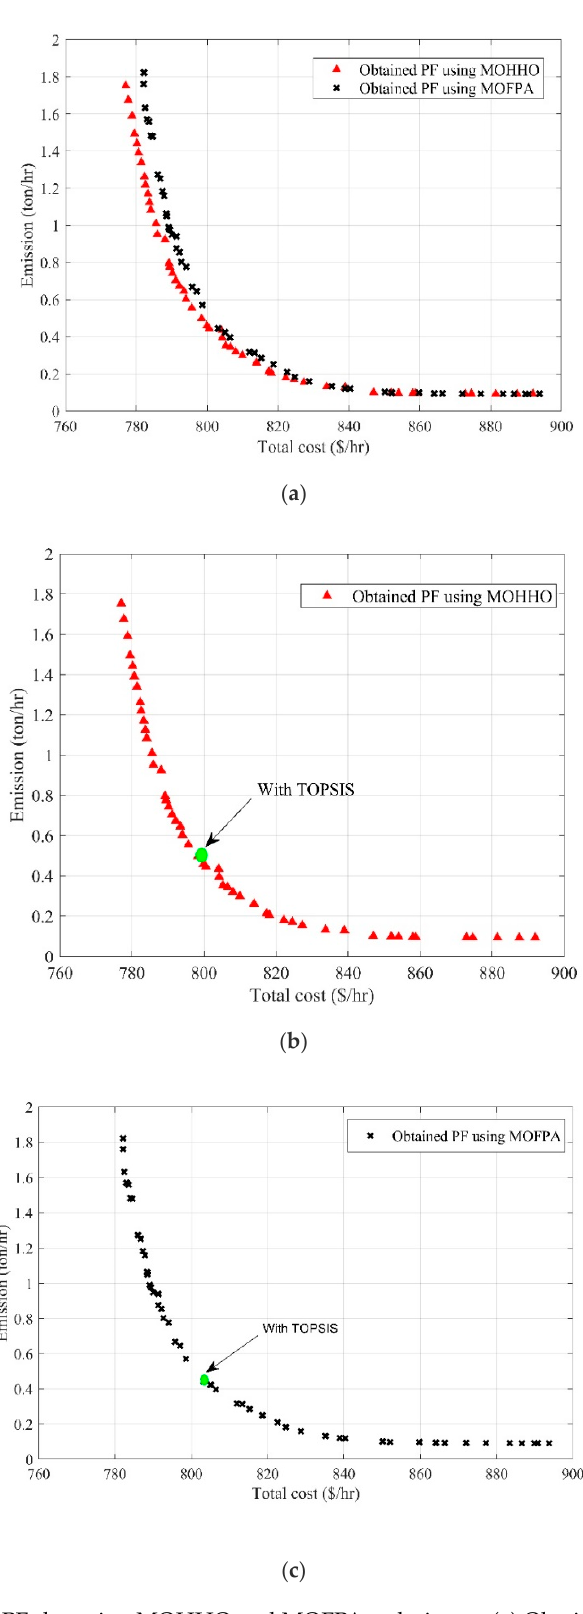
Figure 11. Obtained PFs by using MOHHO and MOFPA techniques. ( a ) Obtained PF using the two optimization techniques. ( b ) Obtained PF using the MOHHO technique with TOPSIS. ( c ) Obtained PF using the MOFPA technique with TOPSIS.